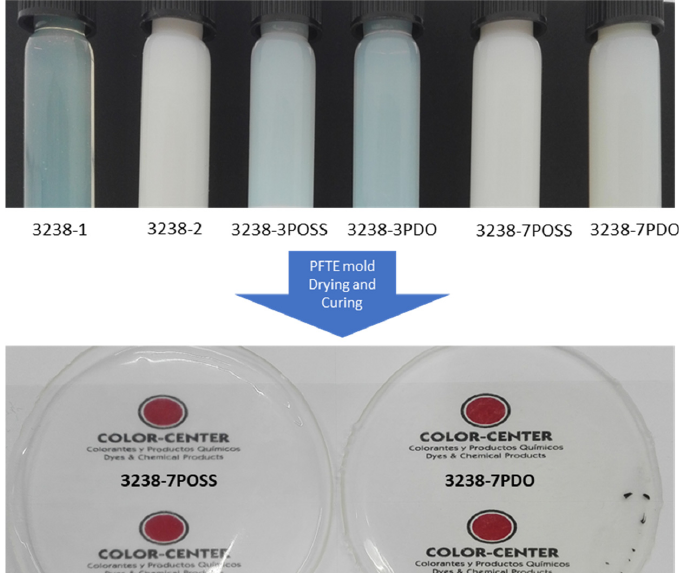
Figure 6. Appearance of the synthesized WPUD ( top ) and casted films ( bottom ) from two of the polyurethane-urea dispersions (3238-7POSS and 3238-7PDO). 1 H NMR spectra of all polymer films were recorded, thus confirming chemical struc- ture. Figures 7 and 8 depict the 1 H NMR spectra of 3238-3PDO and starting Priplast 3238 polyol and 3238-3POSS and starting POSS-OH, respectively, with peak assignments.